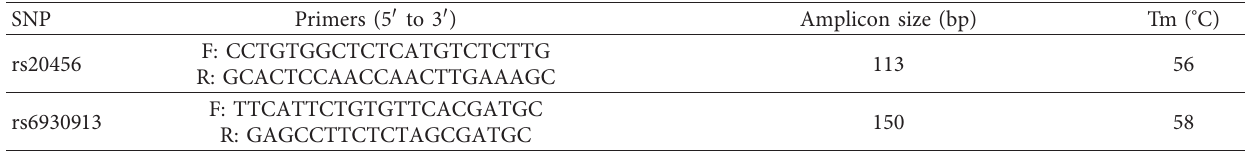
Table 1: PCR profiles (primers, amplicon size, and Tm) of rs20456 and rs6930913 in KIF6.